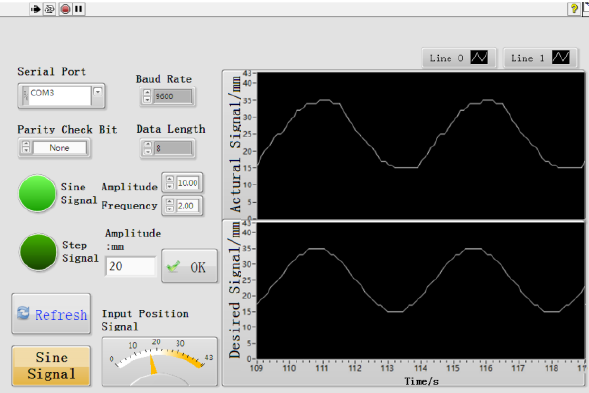
Figure 12. Time response of the hydraulic cylinder position in the tracking of the desired sine signal.